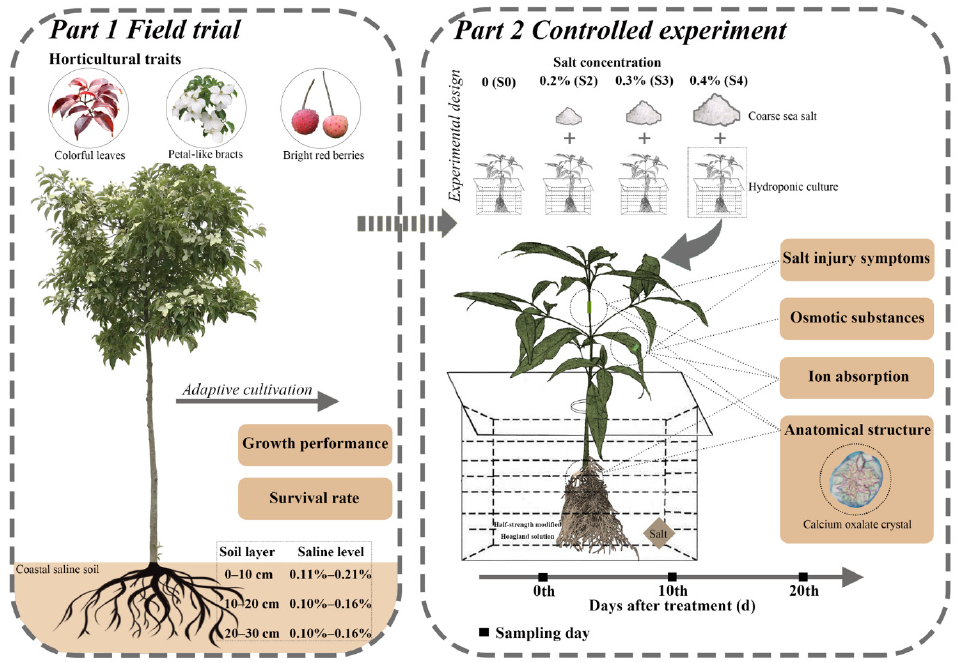
Figure 1. Conceptual map of the experimental design of the field trial and controlled experiment.